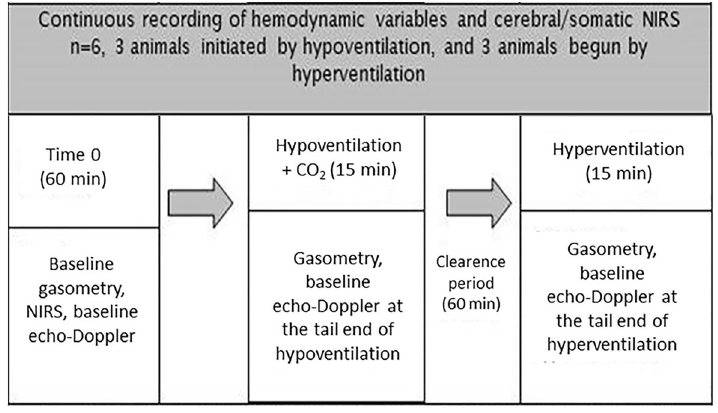
Figure 1. Flowchart showing continuous recording of hemodynamic variables and cerebral/somatic near-infrared spectroscopy (NIRS).